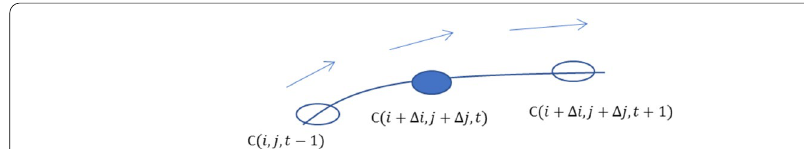
Fig. 5 Example of an object’s movement multiple time steps